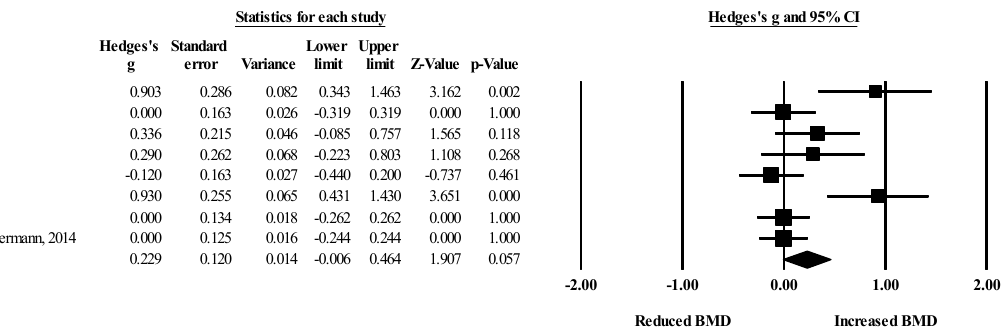
Figure 6. Forest plot of within-group changes in total body bone mineral density (BMD) in untrained adults after a training program based on soccer small-sided games. Values shown are effect sizes (Hedges’s g) with 95% confidence intervals (CI). The size of the plotted squares reflects the statistical weight of each study. The black diamond reflects the overall result.